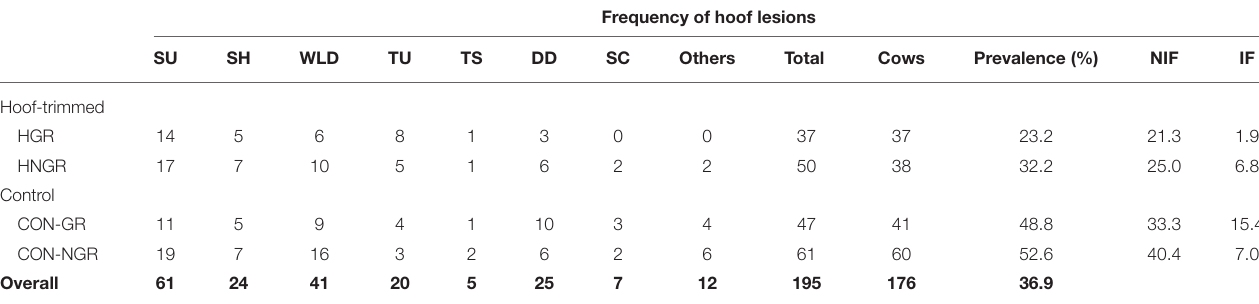
TABLE 5 | Hoof lesion prevalence in trimmed and control cows from grazing ( n = 2) and non-grazing ( n = 3) dairy farms.